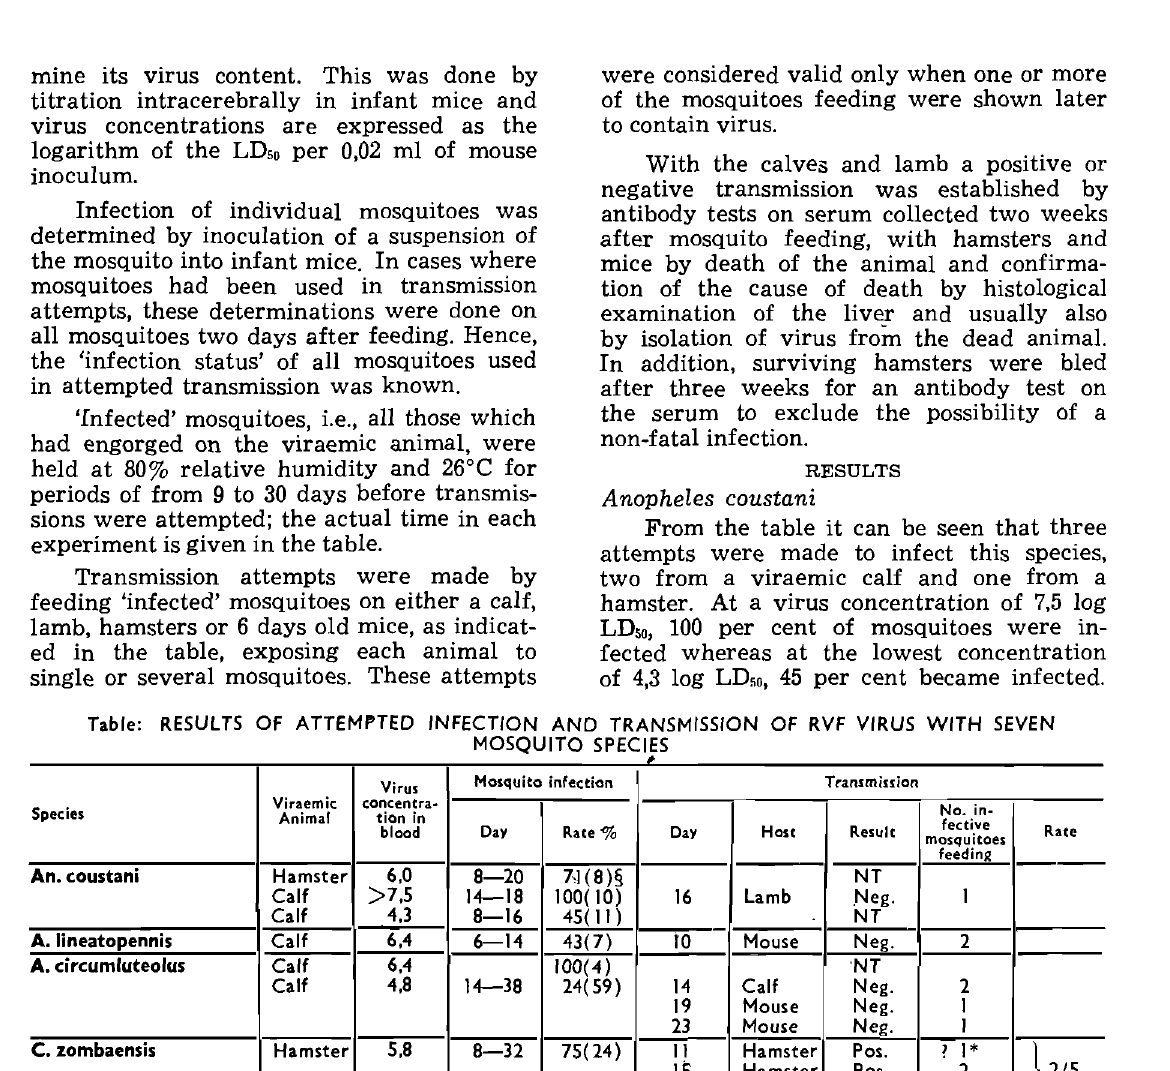
§Figure in parenthesis indicates number of mosquitoes on which percentage is calculated. *Successful transmission resulting from an unknown number of mosquitoes probing but not imbibing blood. tIn all transmission attempts with C. theileri each mouse was exposed to one mosquito. NT=no